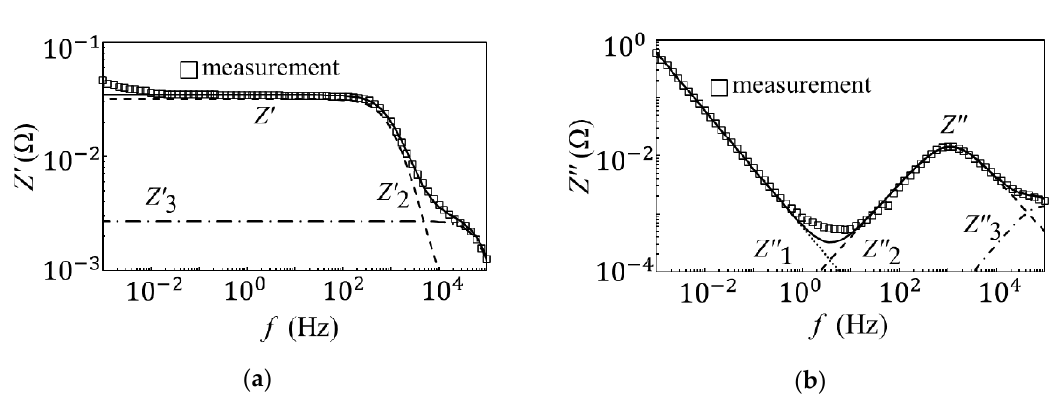
Figure 4. The equivalent circuit analysis of the unused EDLCs. ( a ) The equivalent circuit analysis results for the real part impedance of the unused EDLCs. ( b ) The equivalent circuit analysis results for the imaginary part impedance of the unused EDLCs.